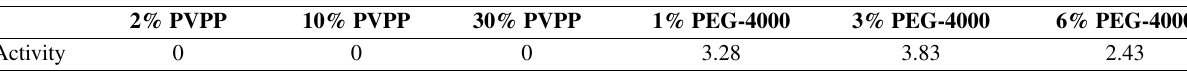
Table 1 . Specific activity (nkat/g FW) of vacINV in extraction buffer A (see Table 2) supplemented with the indicated concentration (w/v) of phe- nolic-binding agent. All extractions were performed on the same biological sample consisting of apical leaves pooled from a single plant, and mea- surements are mean values from duplicate measurements of the same extract.